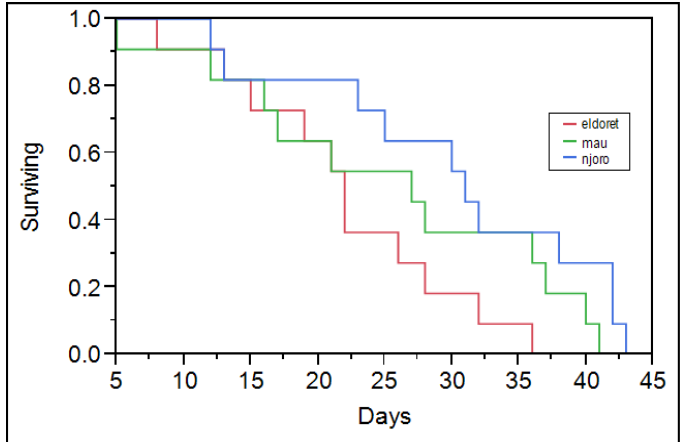
Figure 1. Survivorship curves for Eldoret and Mau Narok and Njoro RWA populations on KRWA9.